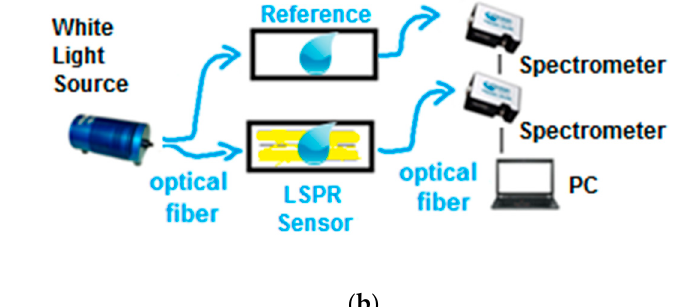
Figure 1. ( a ) SEM image of the bacterial cellulose. ( b ) The experimental setup used to test the plasmonic sensor.